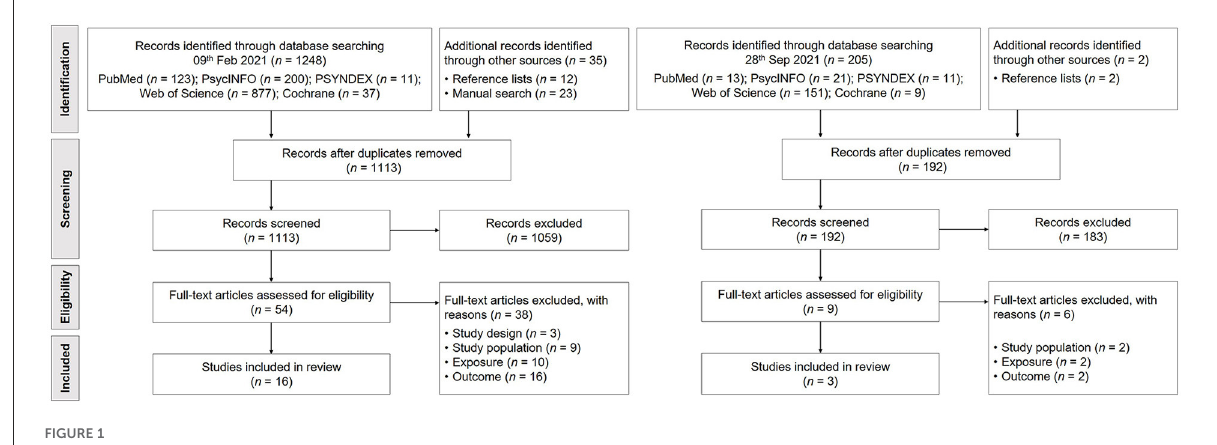
FIGURE1 PRISMA-ScR flow diagram of the study selection